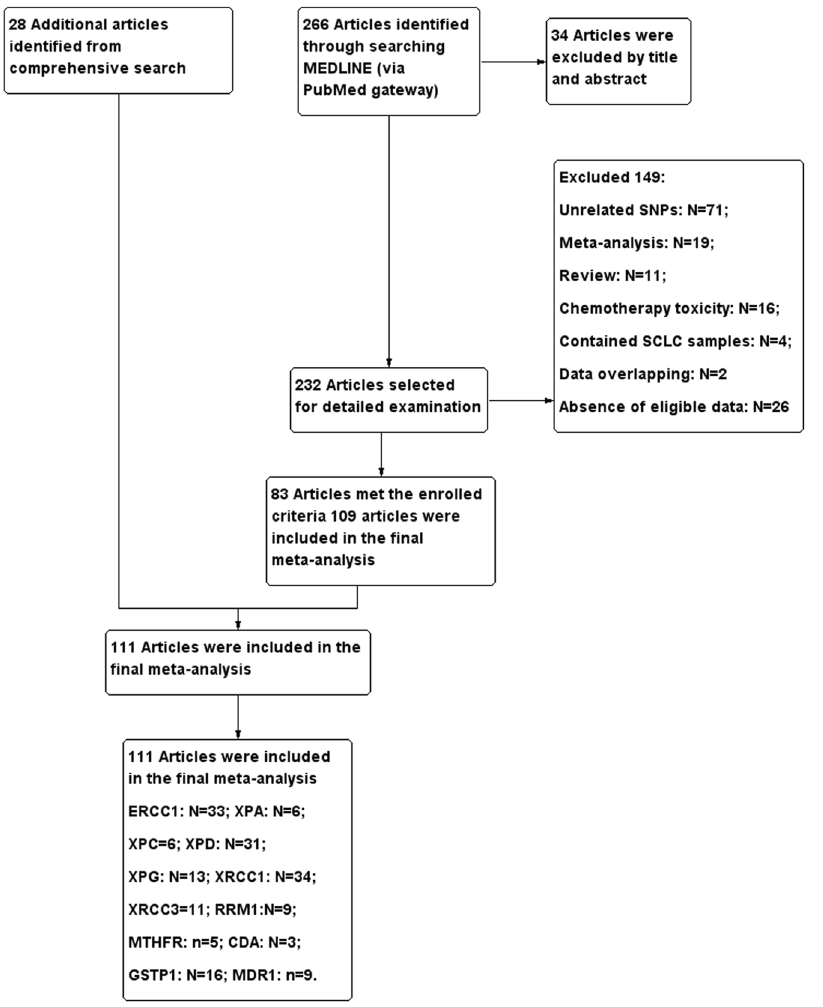
Figure 1. Flow diagram of the study selection process for the current